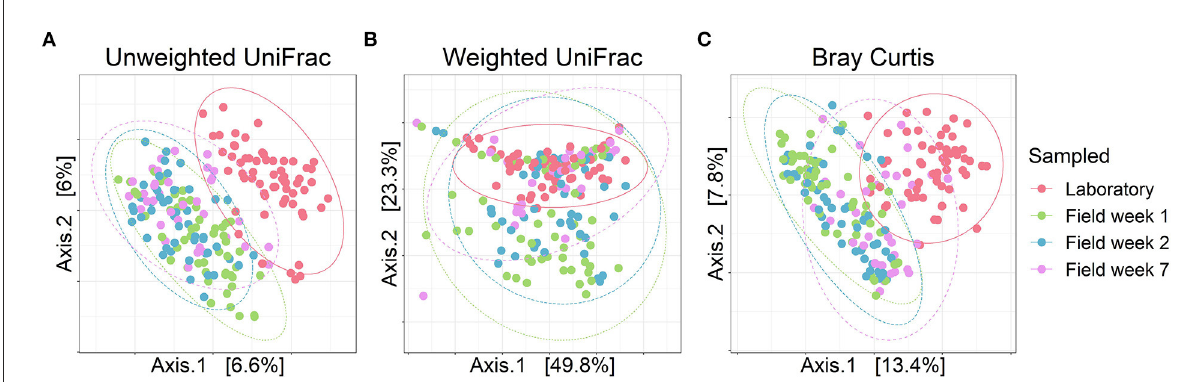
FIGURE2 Bacterial composition of the founder bank vole gut microbiotas throughout the experiment. PCoA plots for (A) Unweighted UniFrac, (B) Weighted UniFrac and (C) Bray–Curtis dissimilarity. Dots represent individual samples, colors represent each sampling event and ellipses indicate 95% confidence intervals. Selection lines (A and C line) are pooled for these analyses.